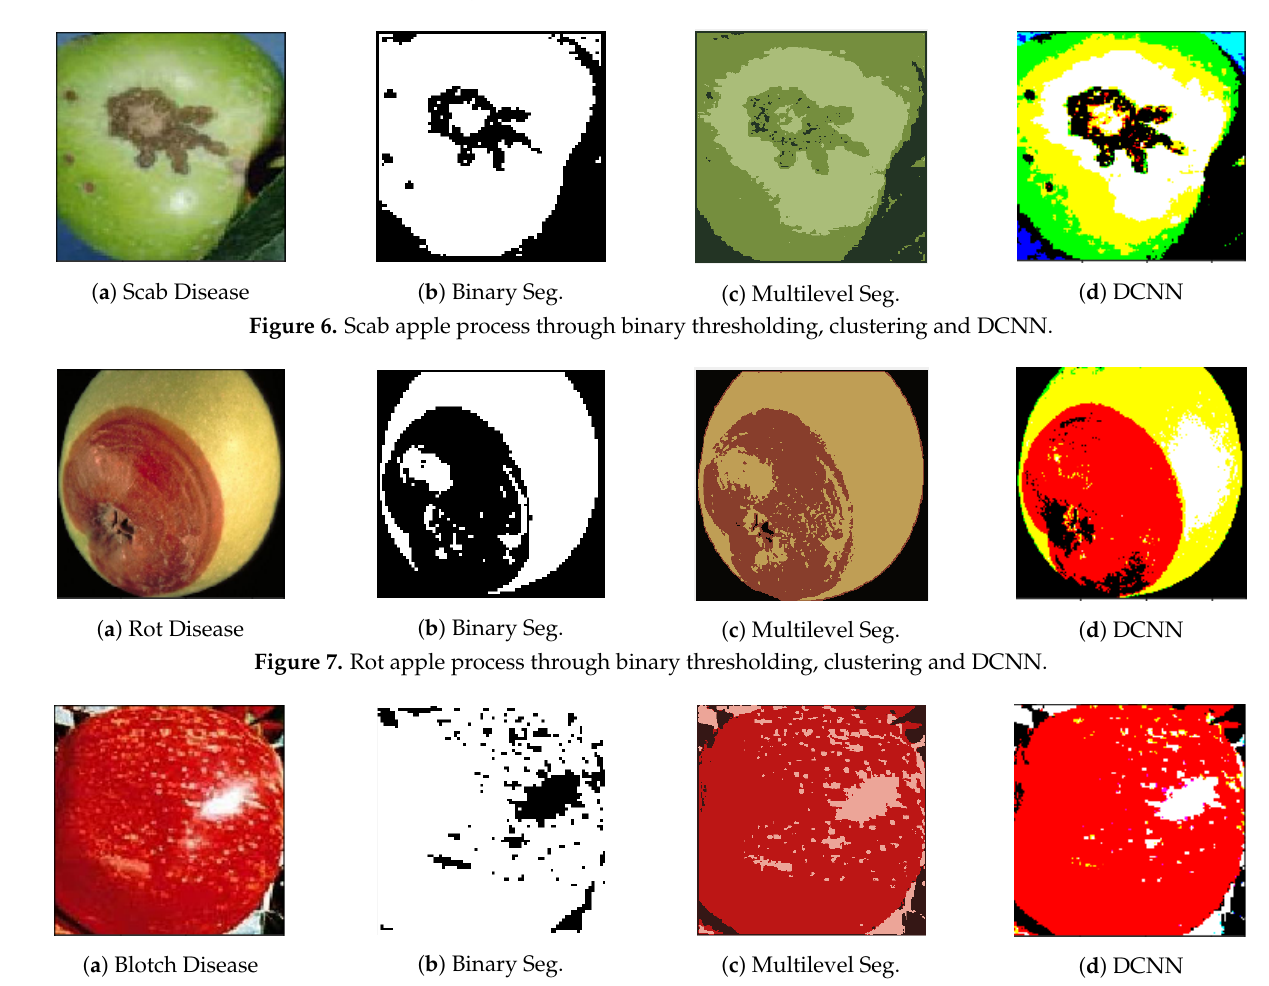
Figure 8. Blotch apple process through binary thresholding, clustering and